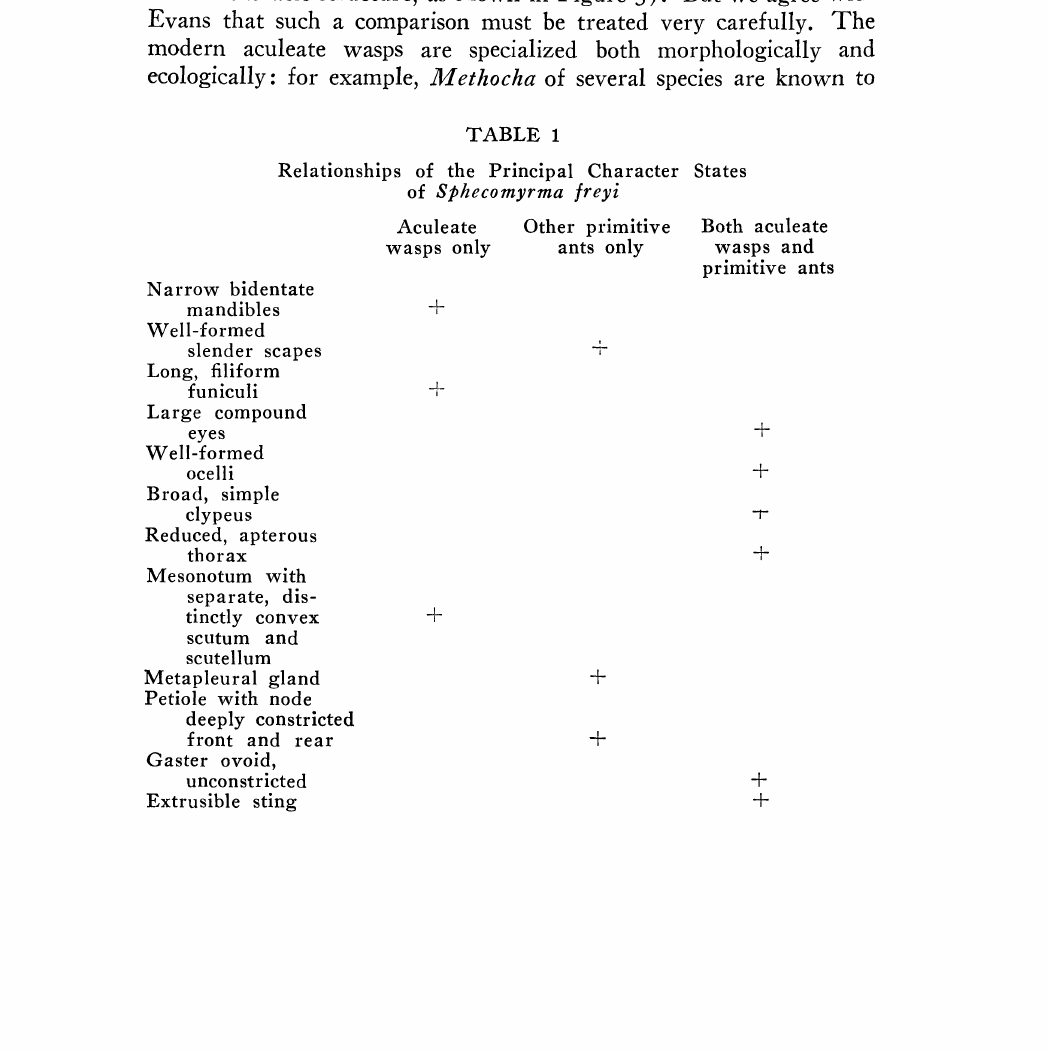
Relationships of the Principal Character States of Sphecomyrma